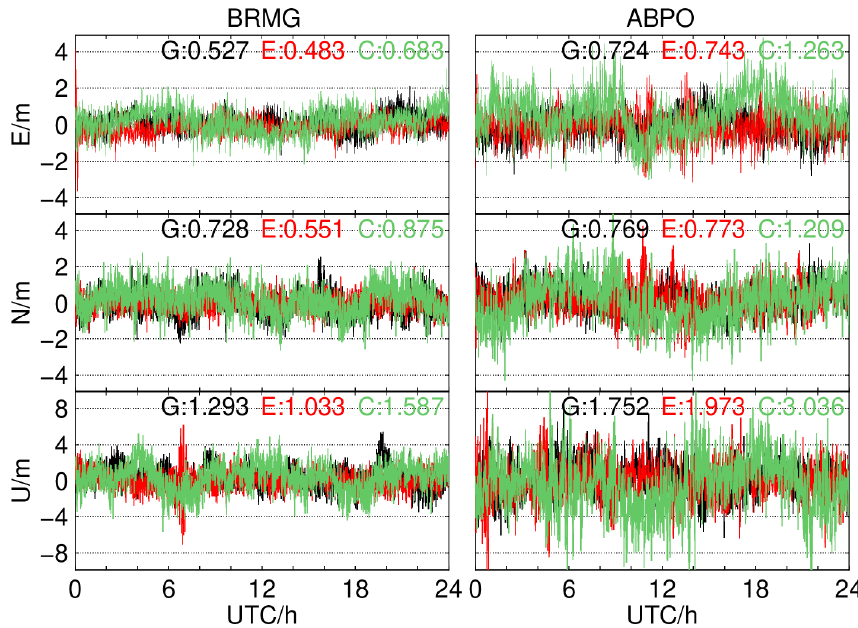
Figure 10. Dual-frequency positioning errors for the E, N, and U components of the two tracking stations of BRMG and ABPO.